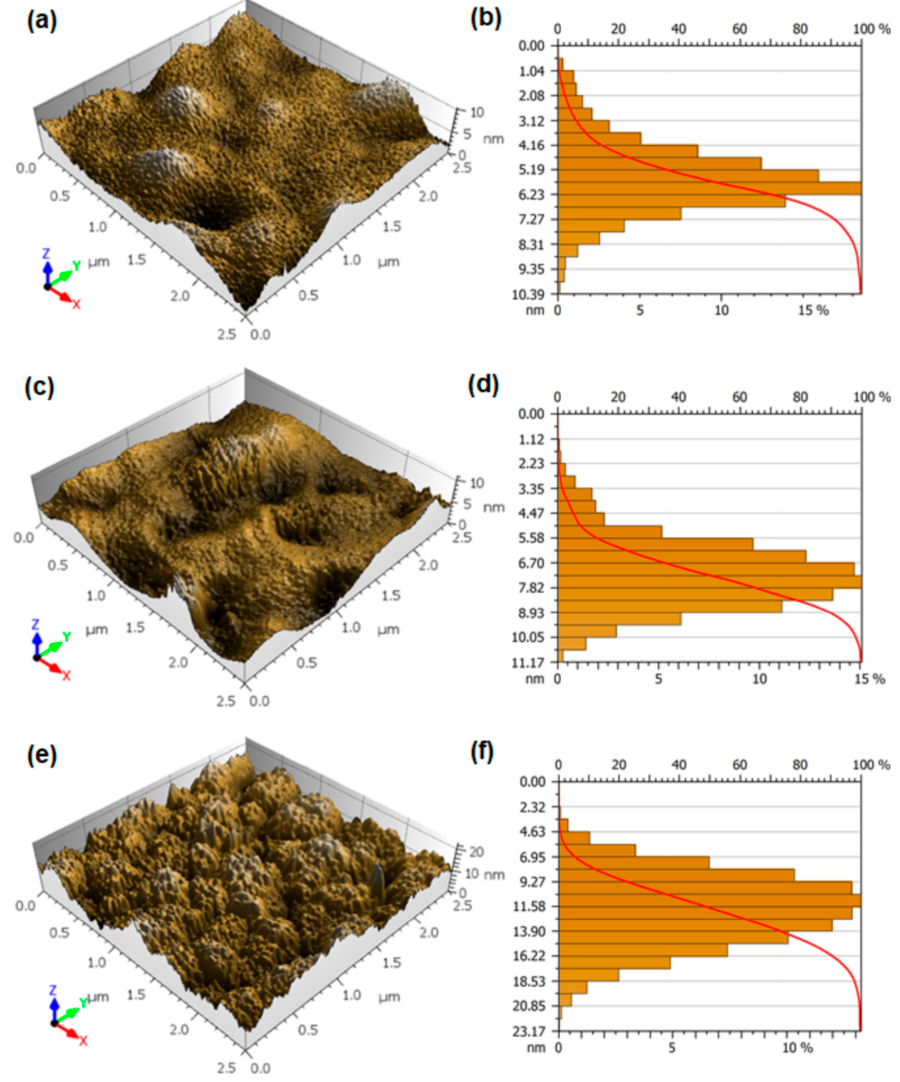
Figure 2. 3D atomic force microscopy (AFM) topographical maps and histogram of relative heights of GdMnO 3 thin films of ( a , b ) GdMnO650, ( c , d ) GdMnO750, and ( e , f ) GdMnO850. Table 2. Height surface parameters of GdMnO 3 thin films, according to ISO